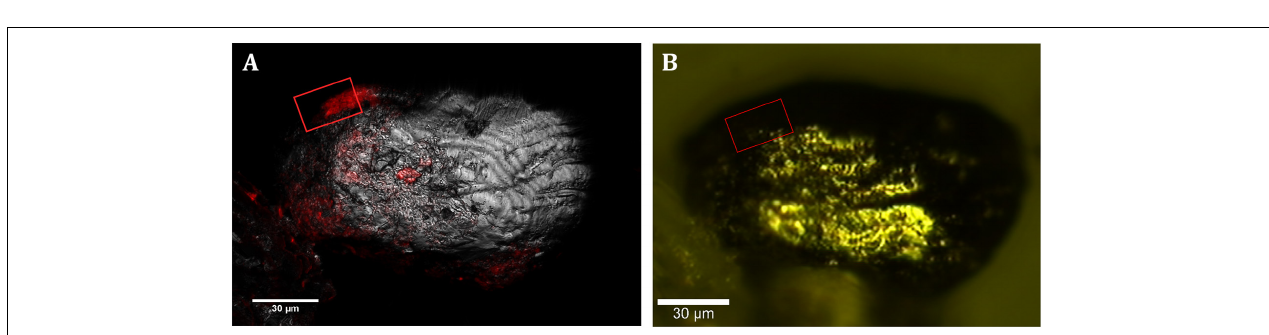
were found attached. Spectrum 3 shows two bands of